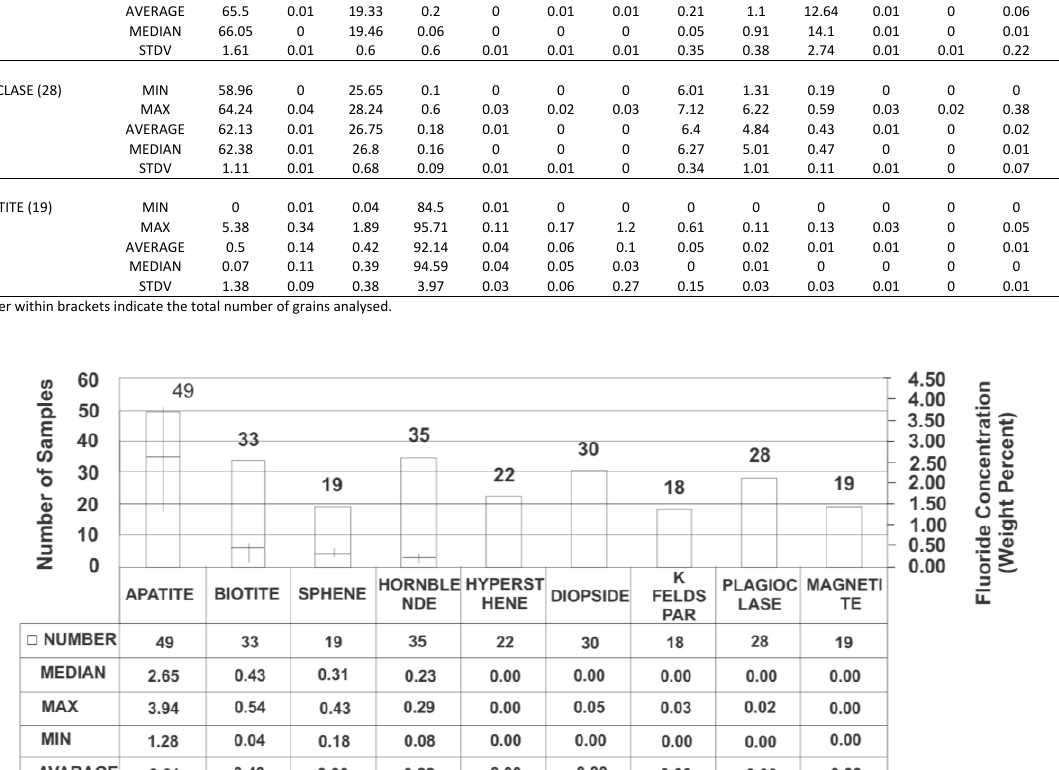
Figure 5: Fluoride concentrations in minerals